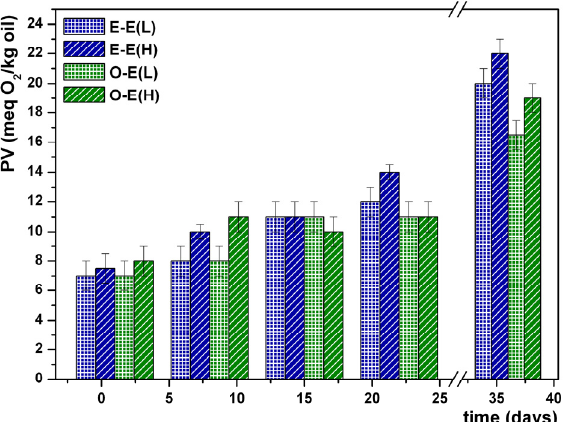
Figure 4. PV as a function of time in: E-E(L) w / o emulsion enriched with low concentration of vitamin E; E-E(H) w / o emulsion enriched with high concentration of vitamin E; O-E(L) oil enriched with low concentration of vitamin E; O-E(H) oil enriched with high concentration of vitamin E (bars represent standard deviation of mean values).